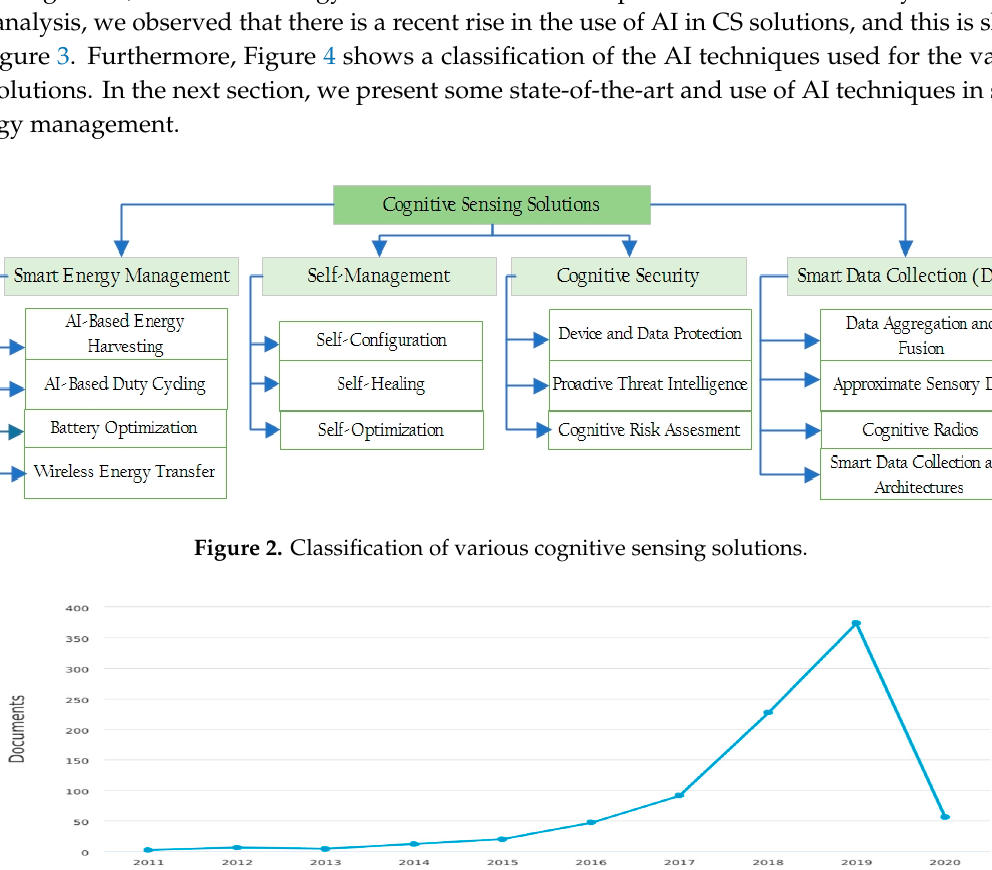
Figure 4. Classification of the surveyed AI techniques .